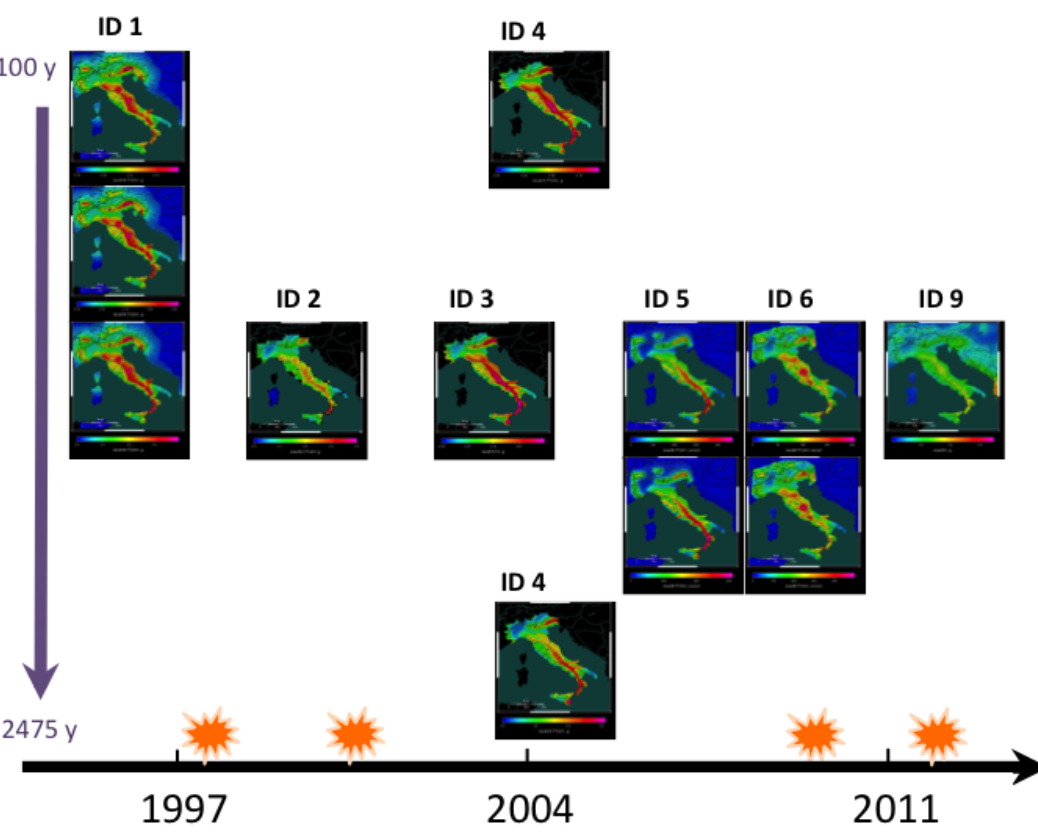
Figure 6. Synoptic view of PSHA maps collected by S2-2012 Project at the national scale. Model ID refers to Table 1; the vertical axis shows approximately the return period the elaborations refer to; on the x -axis, a rough timeline of results release (from 1996 to 2013) with main earthquakes occurrences (orange symbols); full size maps and other graphic details are given in Supplement